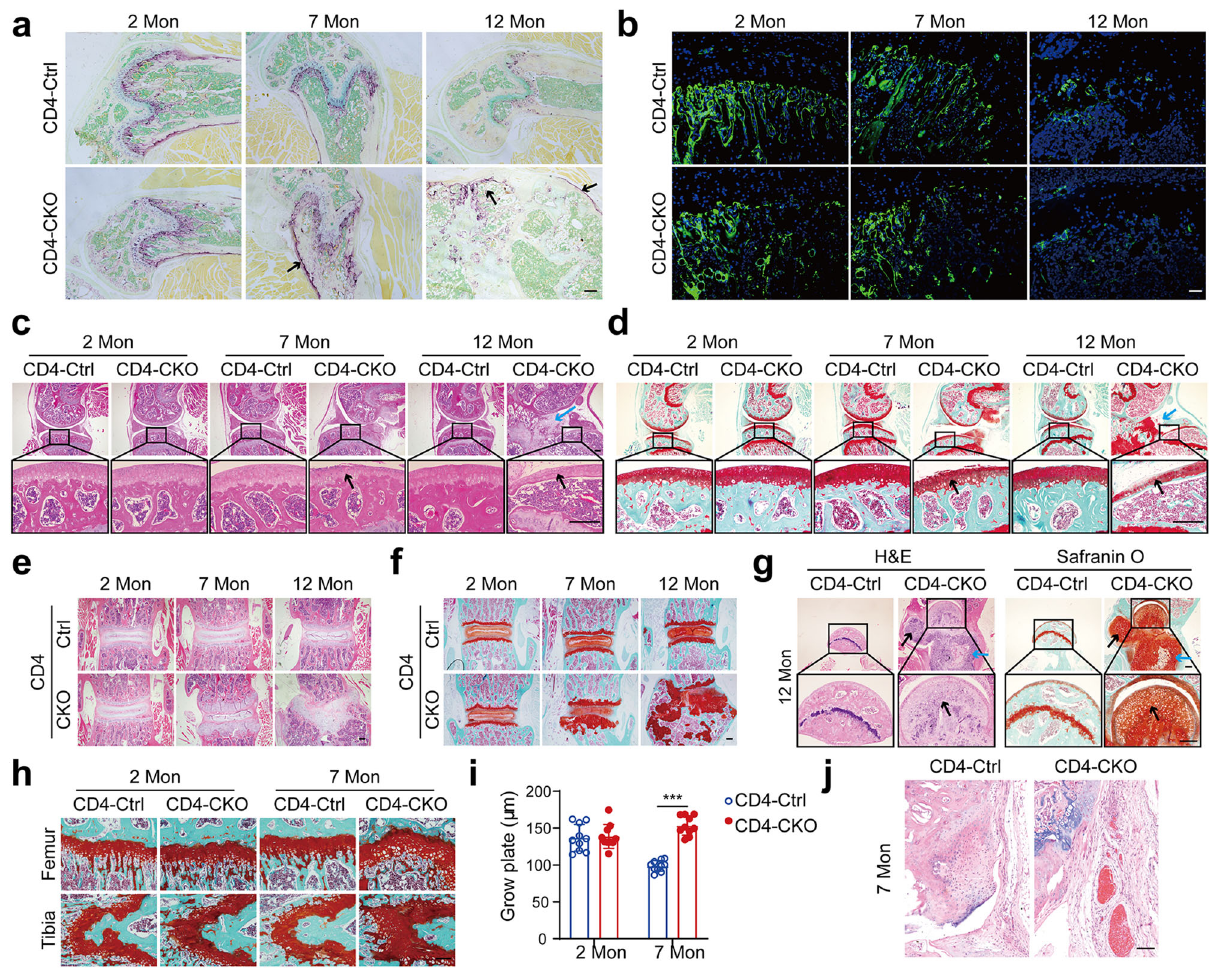
Fig. 2 Ectopic new bone formation is accompanied by aberrant chondrocytes and in fl ammation in CD4-CKO mice. a TRAP staining of distal femur stained. b Osteocalcin immunostaining images of tibia sections. Arrows indicate osteoclasts. c , d H&E and Safranin O-Fast Green (SOFG) analysis of knee joints. Black arrows show degenerated articular cartilage, and blue arrows show ectopic new bone formation in articular cavity and enthesis. e , f H&E and SOFG staining images of spine section. g H&E and SOFG staining images of hip joint section. a – g Scale bars: 200 μ m. c , d , g Black arrows show degenerated articular cartilage, and blue arrows show ectopic new bone formation in articular cavity and enthesis. Data are representative of three independent biological replicates. h , i SOFG staining images and measure of the epiphyseal plate. Scale bars: 50 μ m. i Data are presented as mean ± SEM ( n = 10). *** p < 0.001, determined by two-tailed Student ’ s t -test. j H&E staining images show in fl ammation, pannus formation, and